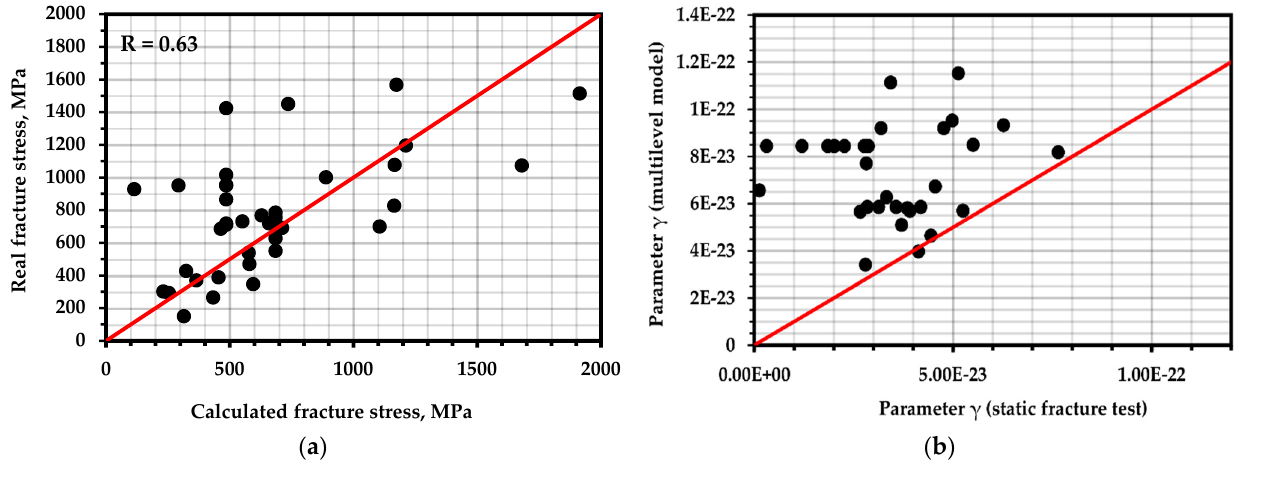
Figure 7. ( a ) Correlation between the actual destructive stress and that calculated by the multilevel AE model; ( b ) correlation between the structural parameter γ calculated from the multilevel AE model and the results of static tests.